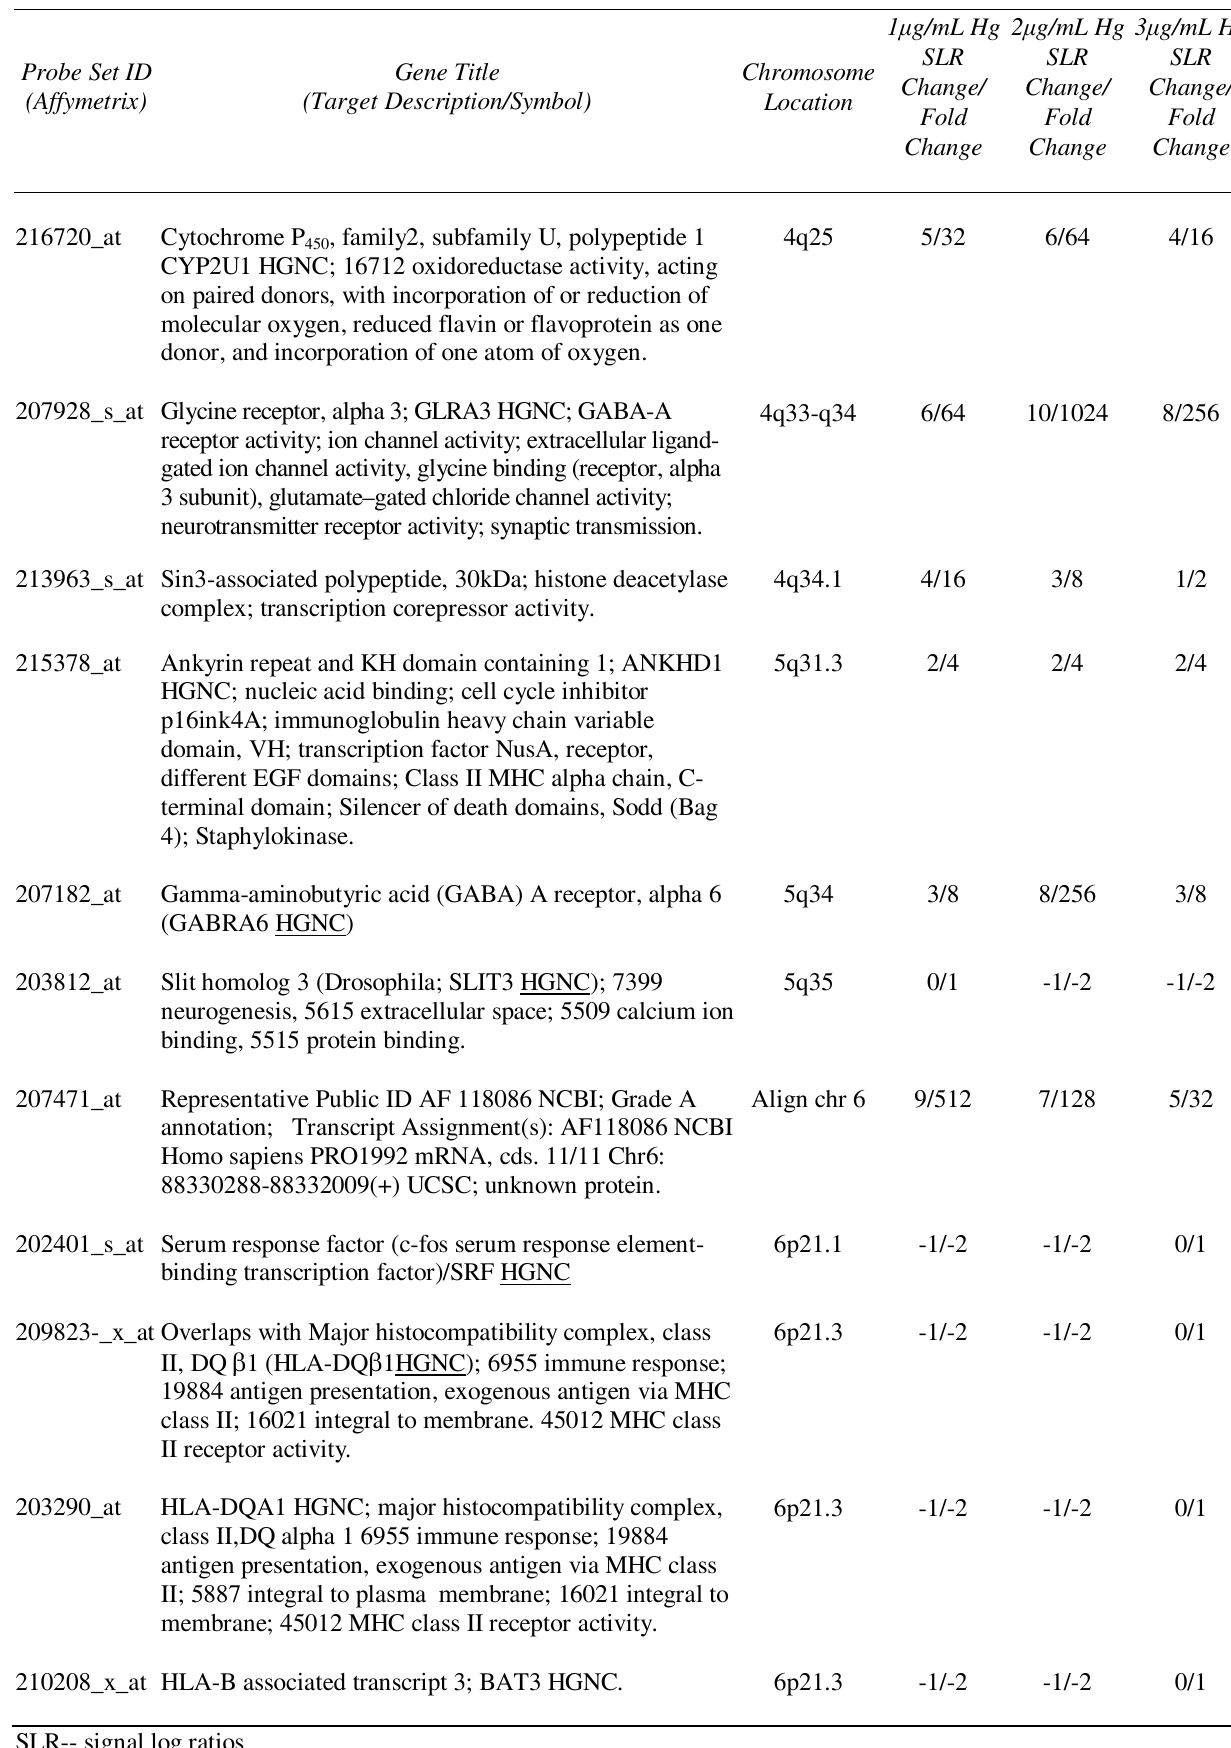
Table 1 contd.: Sample genes affected by